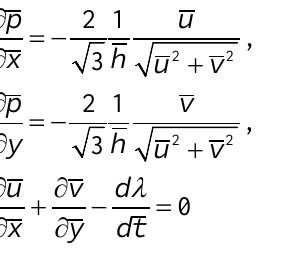
Fig.1. Spreading of the plastic layer in the cross section (a), and in the plan